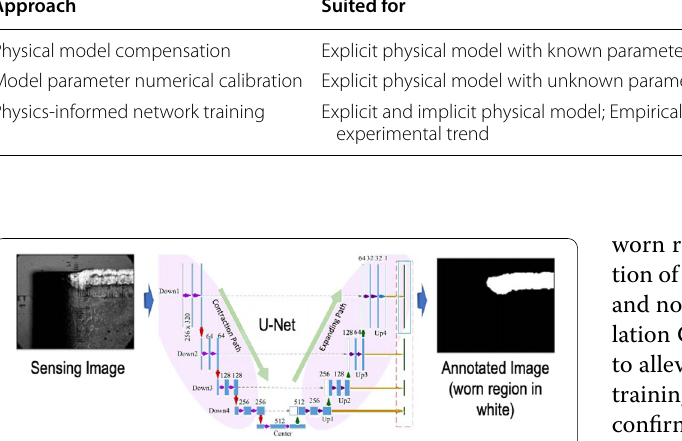
Table 5 Comparison of physical model and neural network integration approach Approach Suited for Not suited for